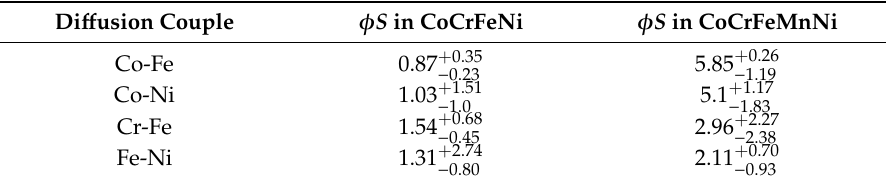
Table 8. φ S for various di ff usion couples at 1423 K